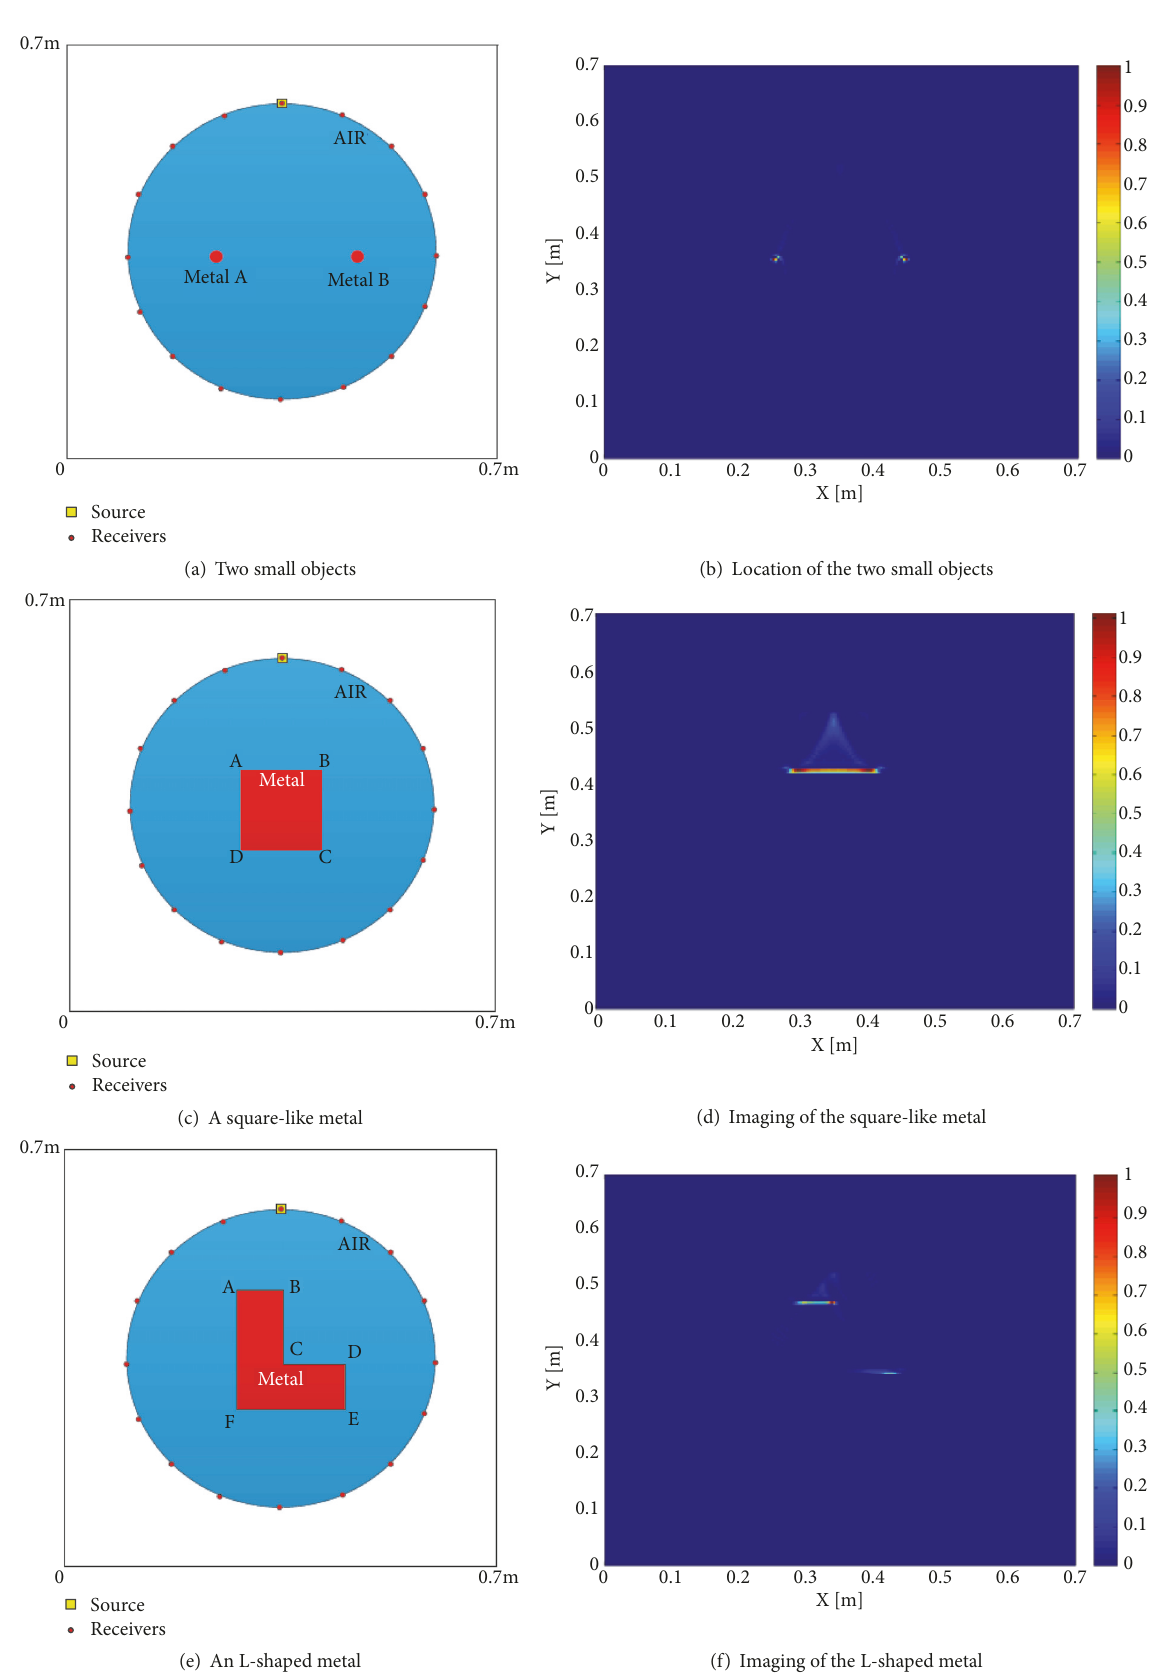
Figure 12: Imaging small and extended metals with a single incoming